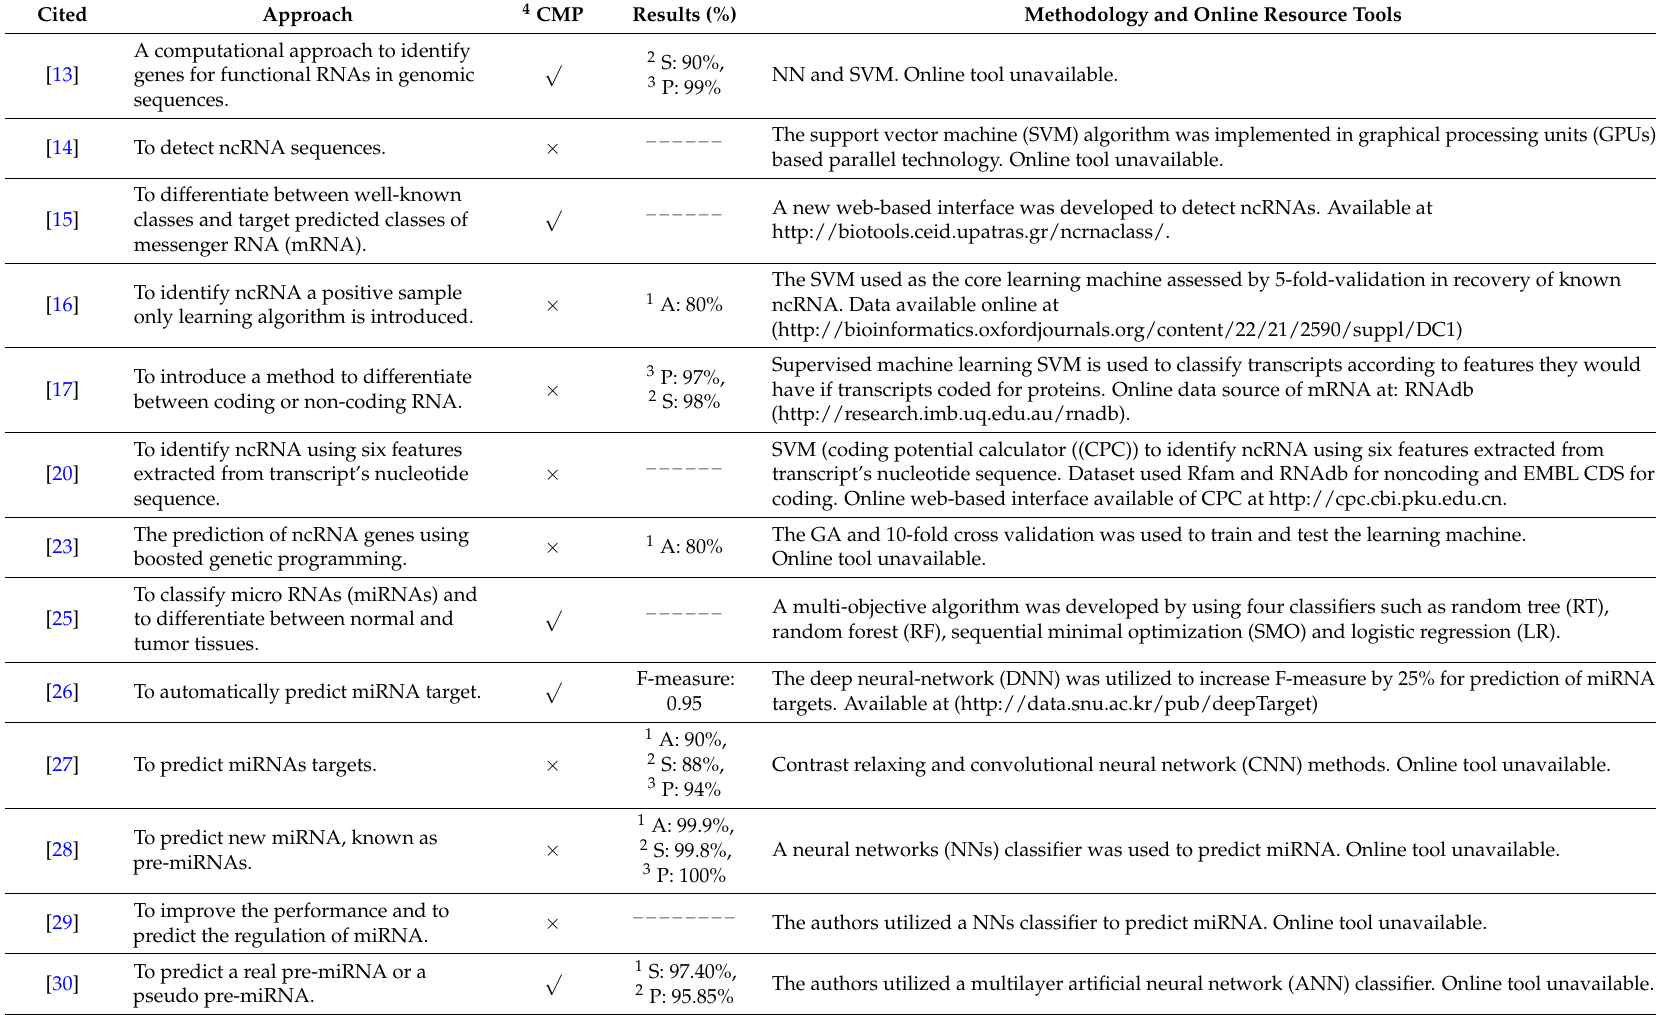
Table 1. State-of-the-art computational intelligence (CI) techniques for finding non-coding RNA (ncRNA) genes from 2001 to 2016. Cited Methodology and Online Resource